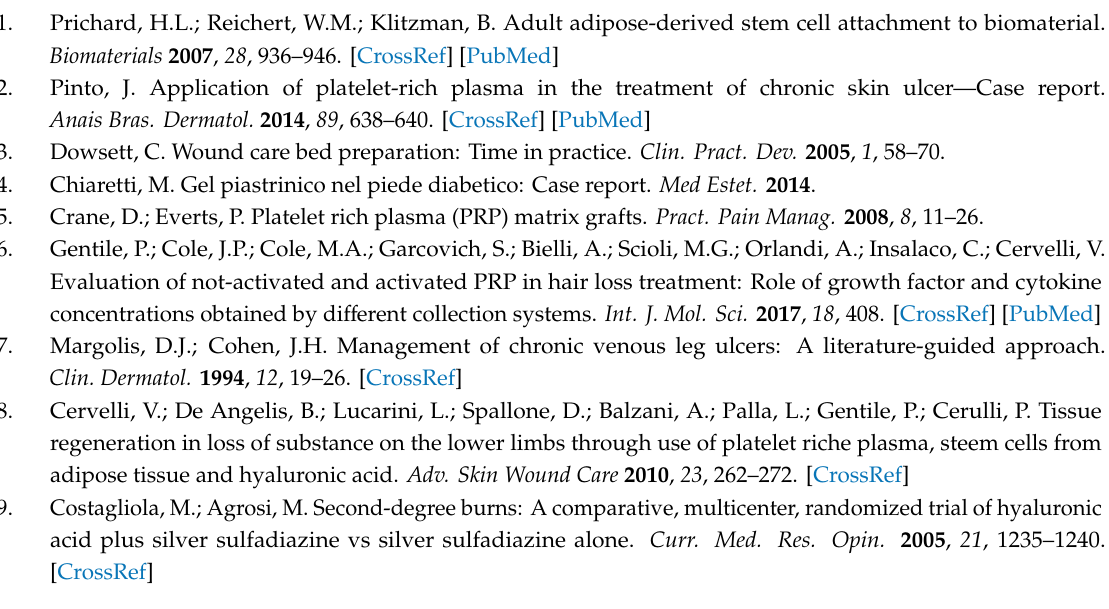
Table S1: Database of the study group’s